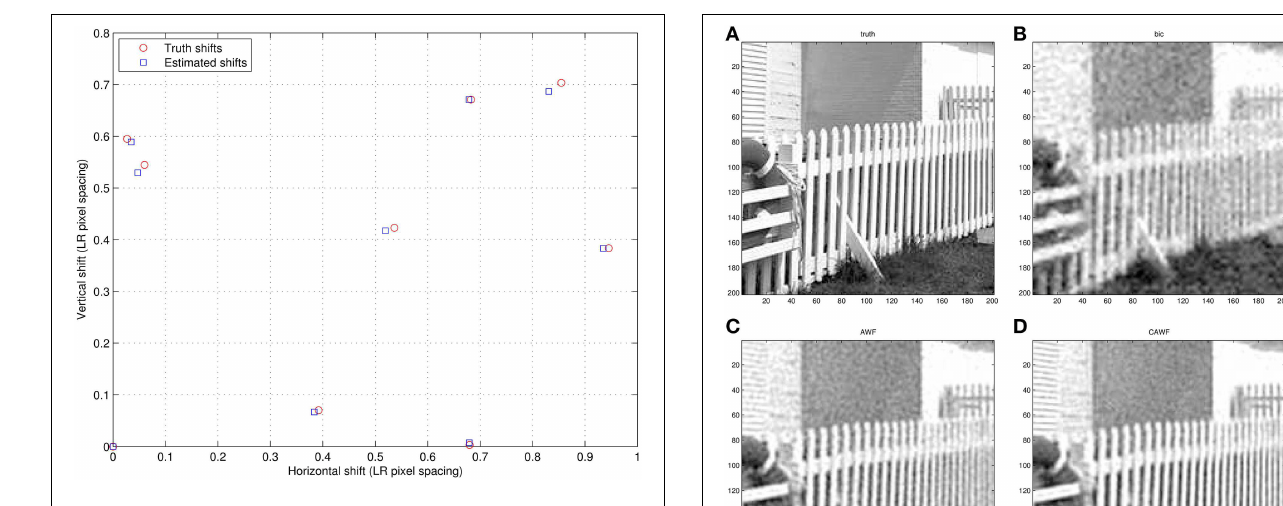
3 , P 9 , and σ η 10 . = = =